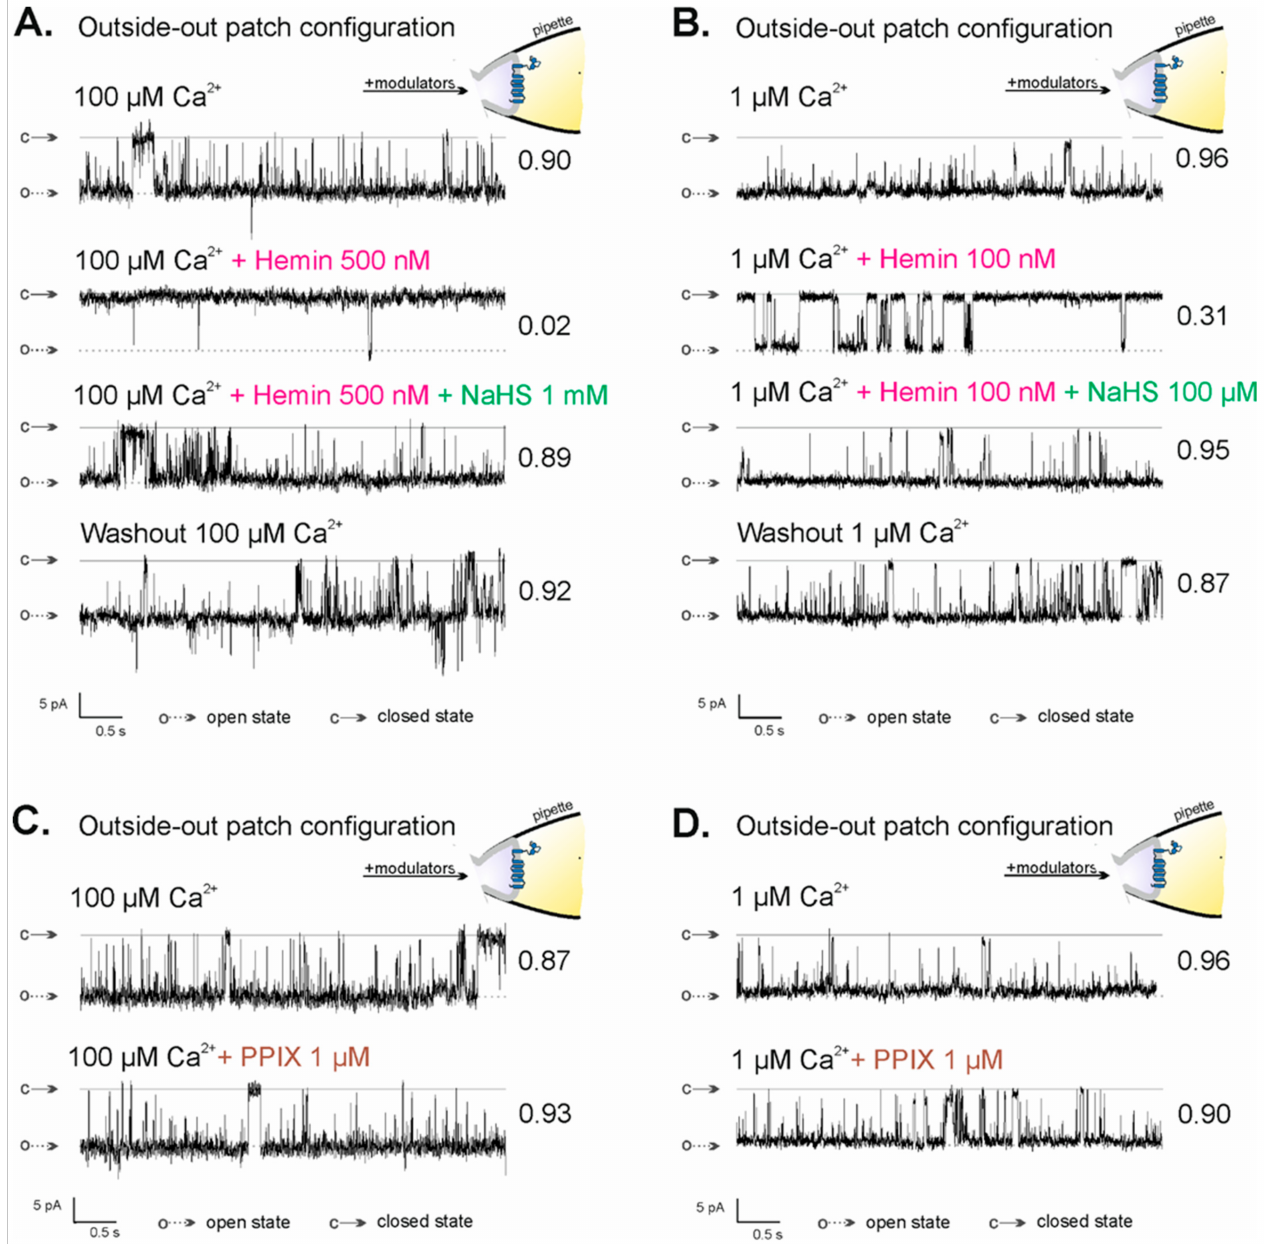
Figure 4. Regulation of the activity of the mitoBK Ca channel in the outside-out configuration by NaHS and PPIX. ( A , B ) NaHS activates mitoBK Ca channels in the outside-out configuration inhibited by external hemin. Representative recordings of single-mitoBK Ca channel activity in outside-out configuration at − 40 mV in control conditions (( A ) 100 µ M Ca 2+ and ( B ) 1 µ M Ca 2+ ) and after the application of hemin followed by NaHS addition and washout step. ( C , D ) Lack of the effect of PPIX on the activity of the mitoBK Ca channel in the outside-out configuration. Representative recordings of single-mitoBK Ca channel activity in the outside-out configuration at − 40 mV in control conditions (( C ) 100 µ M Ca 2+ and ( D ) 1 µ M Ca 2+ ) and after the application of 1 µ M PPIX; “c” denotes the closed state of the channel; “o” denotes the open state of the